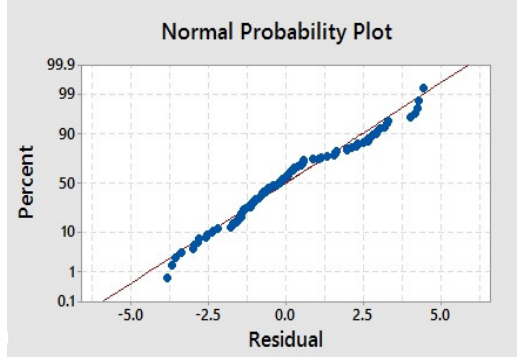
Fig. 1. Residual plot for T cell